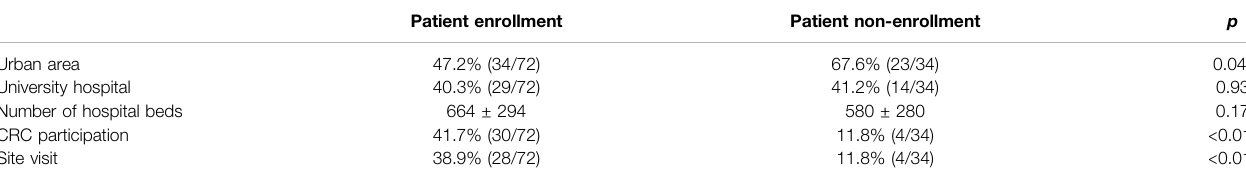
TABLE 1 | Demographic characteristics ( n (cid:1) 106).